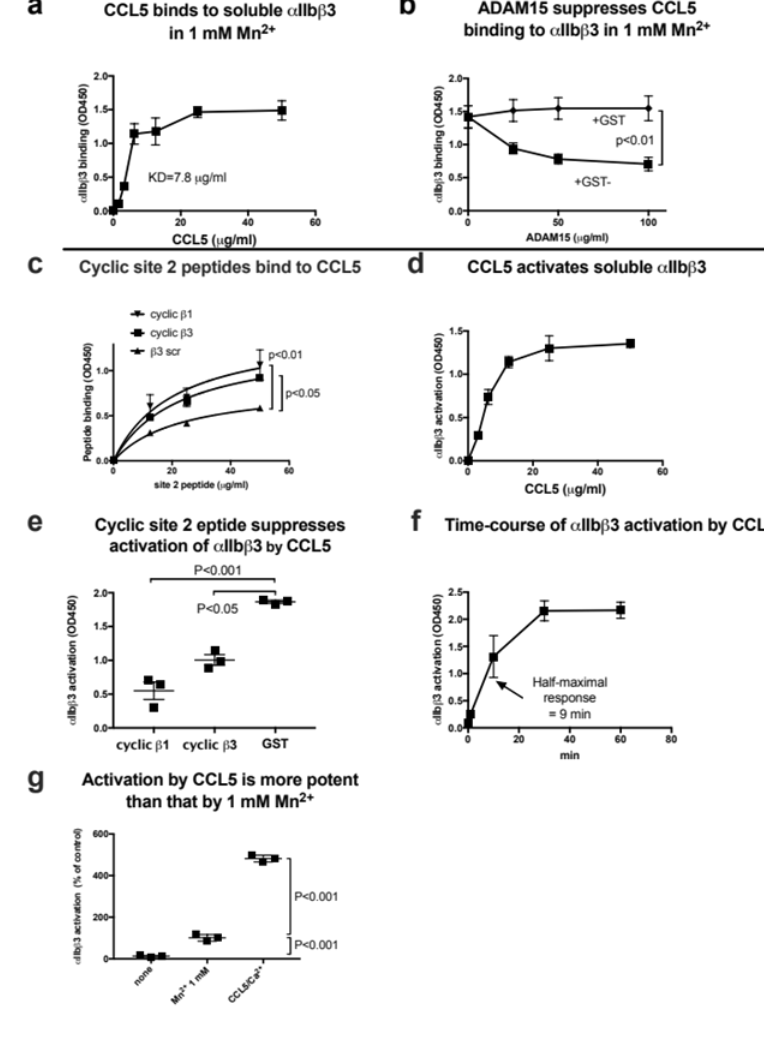
Figure 3. CCL5 binds to and activates soluble integrin αIIbβ3 in cell -free conditions. ( a ) Binding of soluble integrin αIIbβ3 to CCL5 in 1 mM Mn 2+ in cell-free conditions. Wells of 96-well microtiter plates were coated with CCL5 and remaining protein-binding sites were blocked with BSA. Wells were incubated with soluble αIIbβ3 (1 μg/mL) in Tyrode -HEPES buffer with 1 mM Mn 2+ (to activate αIIbβ3) for 1 h at room temperature. After washing the wells to remove unbound integrin, bound αIIbβ3 was quantified using anti - β3 mAb (AV10) and HRP -conjugated anti mouse IgG. Data are shown as means +/− SD in triplicate experiments. ( b ) ADAM15 disintegrin, another ligand for αIIbβ3, suppressed CCL5 binding to αIIbβ3. ADAM15 disintegrin fused to GST or control GST were included in the binding assay as described in ( a ). ( c ) Binding of cyclic site 2 peptides to CCL5. Wells of 96-well microtiter plates were coated with C CL5 (20 μg/mL) and remaining protein binding sites were coated with BSA. Wells were then incubated with cyclic β3 or β1 site 2 peptide fused to GST or control β3 scrambled peptide for 1 h at room temperature and bound site 2 peptide was quanti- fied using HRP-conjugated anti- GST antibodies. Data are shown as means +/− SD in triplicate ex- periments. ( d ) Activation of soluble αIIbβ3 by CCL5 in 1 mM Ca 2+ . Wells of 96-well microtiter plates were coated with γC390 - 411 (the αIIbβ3 -ligand peptide conjugated to GST) (20 μg/mL) and the re- maining protein- binding site were blocked with BSA. Wells were incubated with soluble αIIbβ3 (1 μg/mL) in Tyrode -HEPES buffer with 1 mM Ca 2+ for 1 h at room temperature in the presence of CCL5. After removing the unbound integrin, boun d αIIbβ3 was quantified using anti - β3 mAb (AV10) and HRP- conjugated anti mouse IgG. Data are shown as means +/− SD in triplicate experi- ments. ( e ) Effect of site 2 peptide on αIIbβ3 activation by CCL5. Activation of αIIbβ3 by CCL5 was assayed as described i n (d) except that cyclic site 2 peptides or control GST (100 μg/mL each) were included as a competitor. Data are shown as means +/− SD in triplicate experiments . ( f ) Time-course of activation of soluble αIIbβ3 by CCL5. Wells of 96-well microtiter plates we re coated with γC390